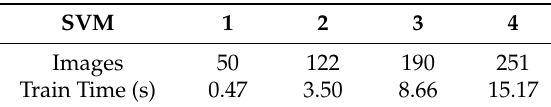
Table 7. SVM training